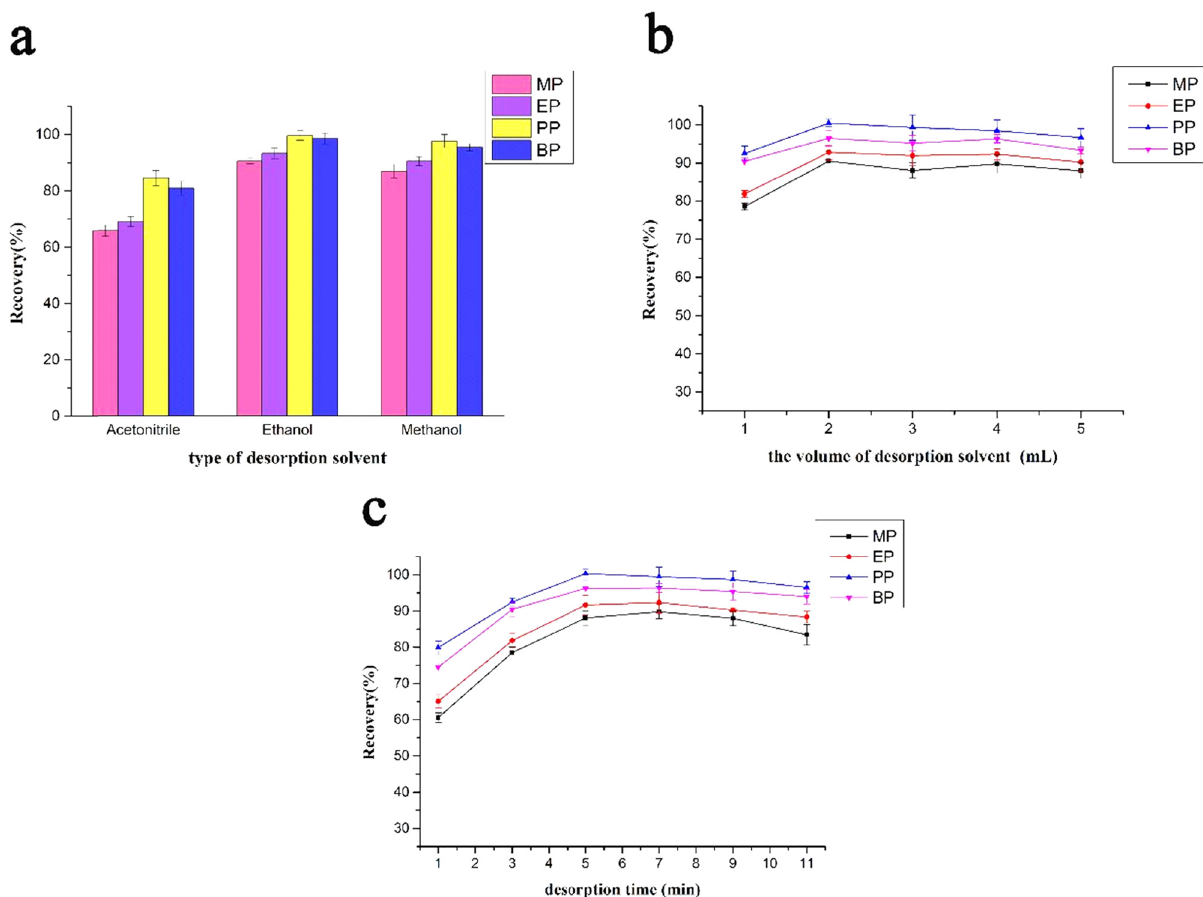
Figure 6: Optimization of elution parameters for MSPE including ( a ) type of desorption solvent, ( b ) volume of desorption, and ( c ) time of desorption.